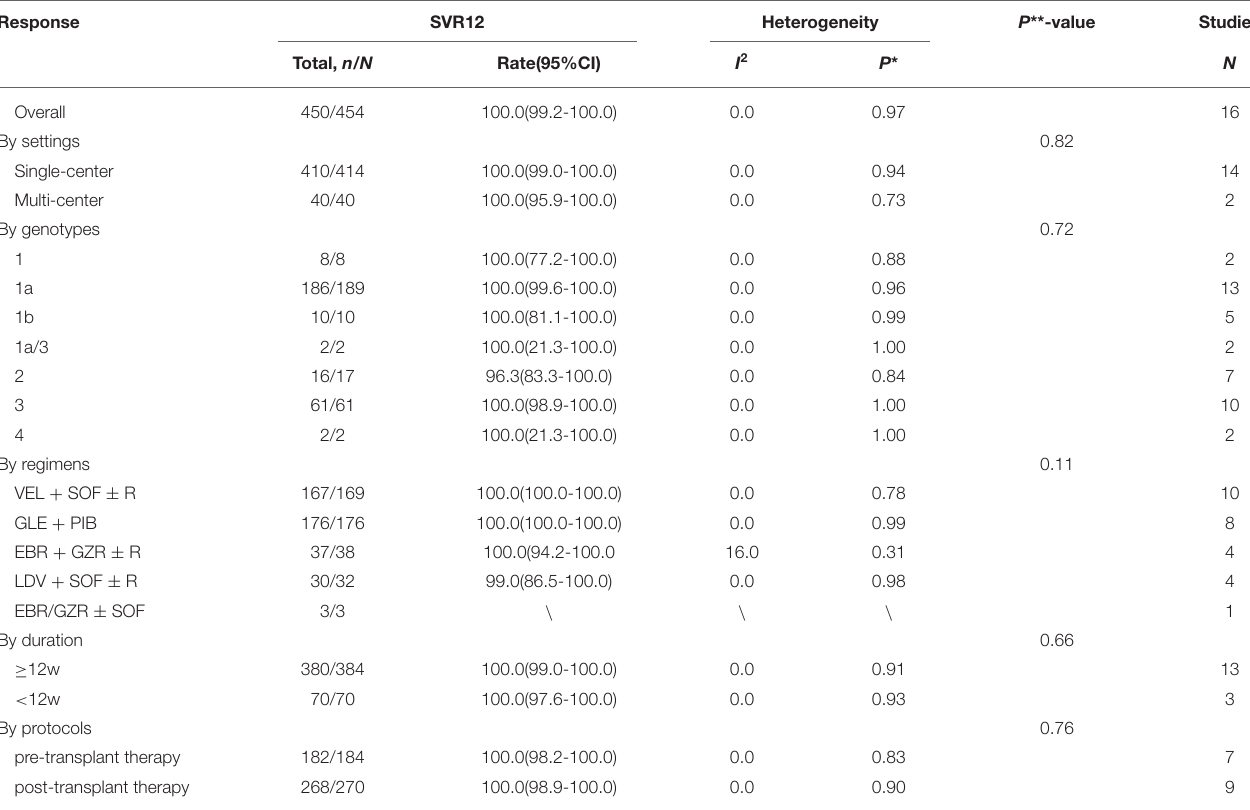
TABLE 3 | SVR12 by settings, genotypes, regimens, durations, and protocols. Response